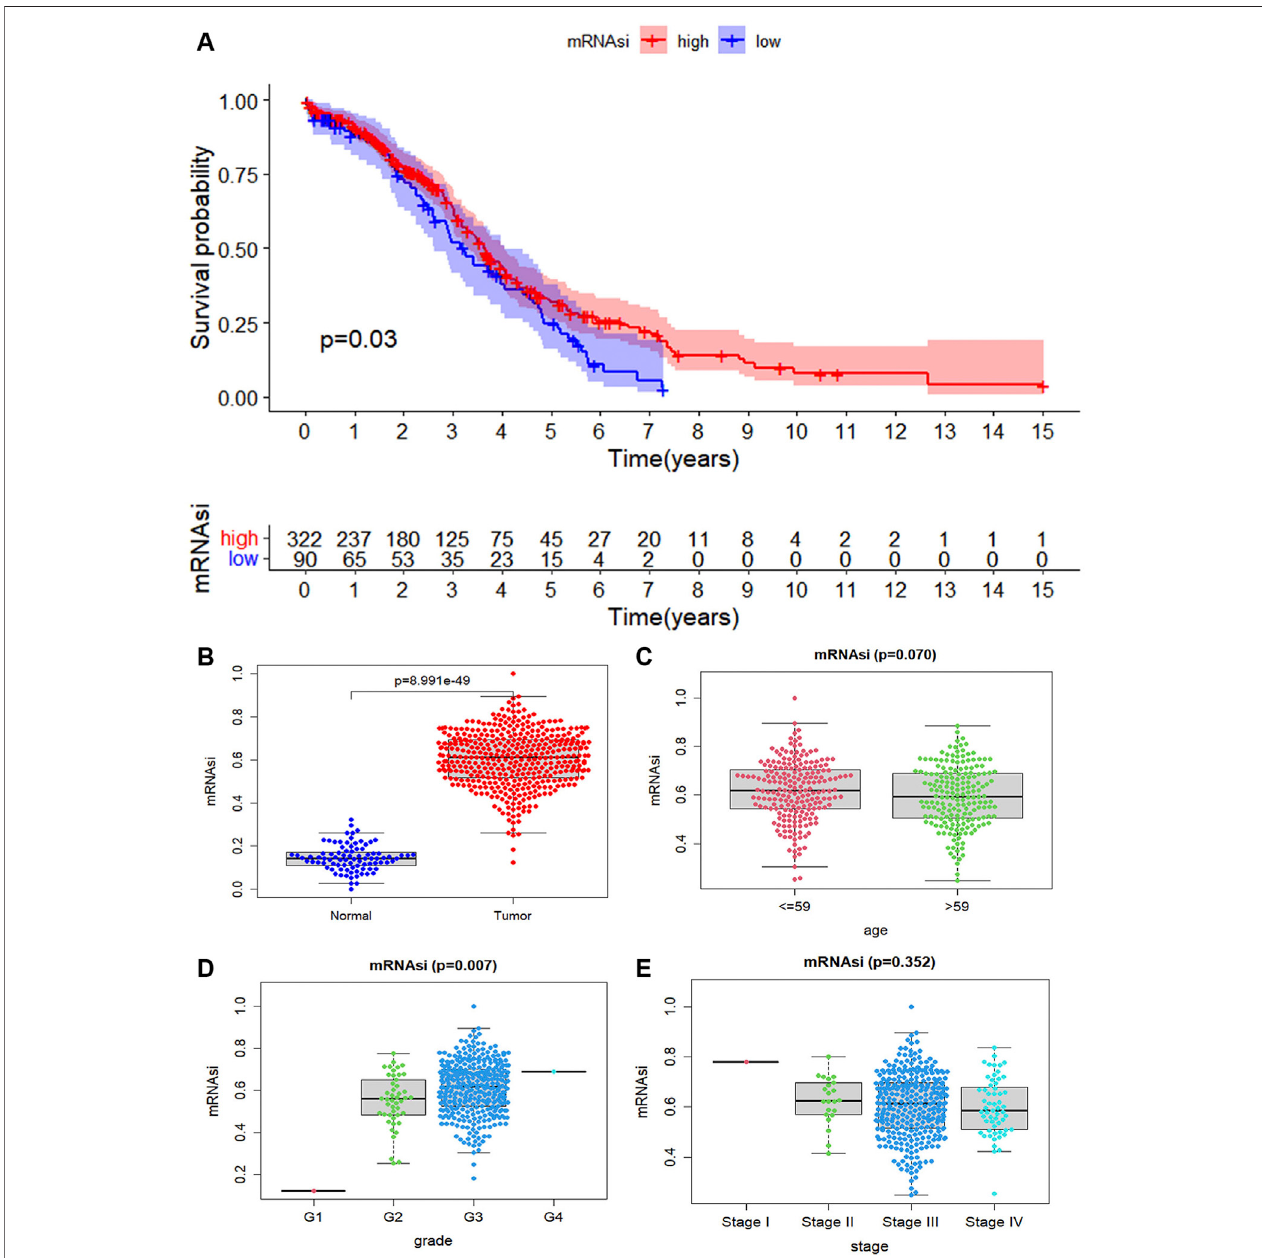
FIGURE 2 | The correlation of mRNAsi index with ovarian cancer. (A) The scatter plot shows that the mRNAsi expression in 416 tumor cases is higher than that in 88normalcases( p -value < 0.05). (B) ThetumorcaseisdividedintotwogroupsbasedontheirmRNAsiscore.TheKaplanMeiersurvivalcurveshowsthatthelowgroup enjoyedalowersurvivalprobability. Anditissigni fi cantstatistical differences asawhole( p -value < 0.05). (C) Thetumor cases aredividedintotwogroups basedon their age (median age = 59), it is no statistical differences ( p = 0.07). (D) The distribution of the mRNAsi for the clinical grade. The mRNAsi scores increase in more advanced clinical grades, and extremely so in G4 ( p = 0.07). (E) The distribution of mRNAsi scores for stage of ovarian cancer